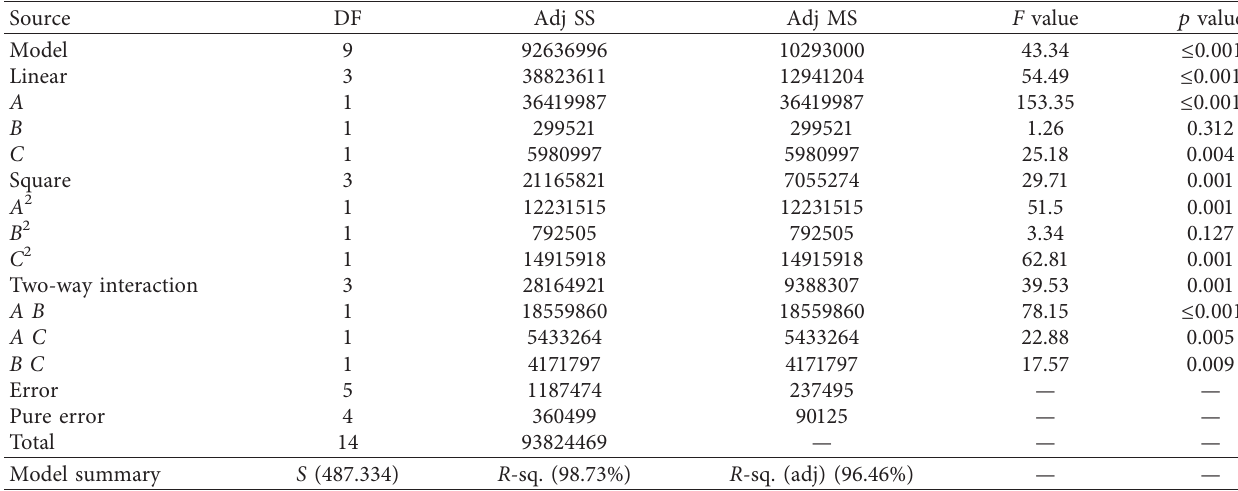
Table 6: Analysis of variance for chip frequency.